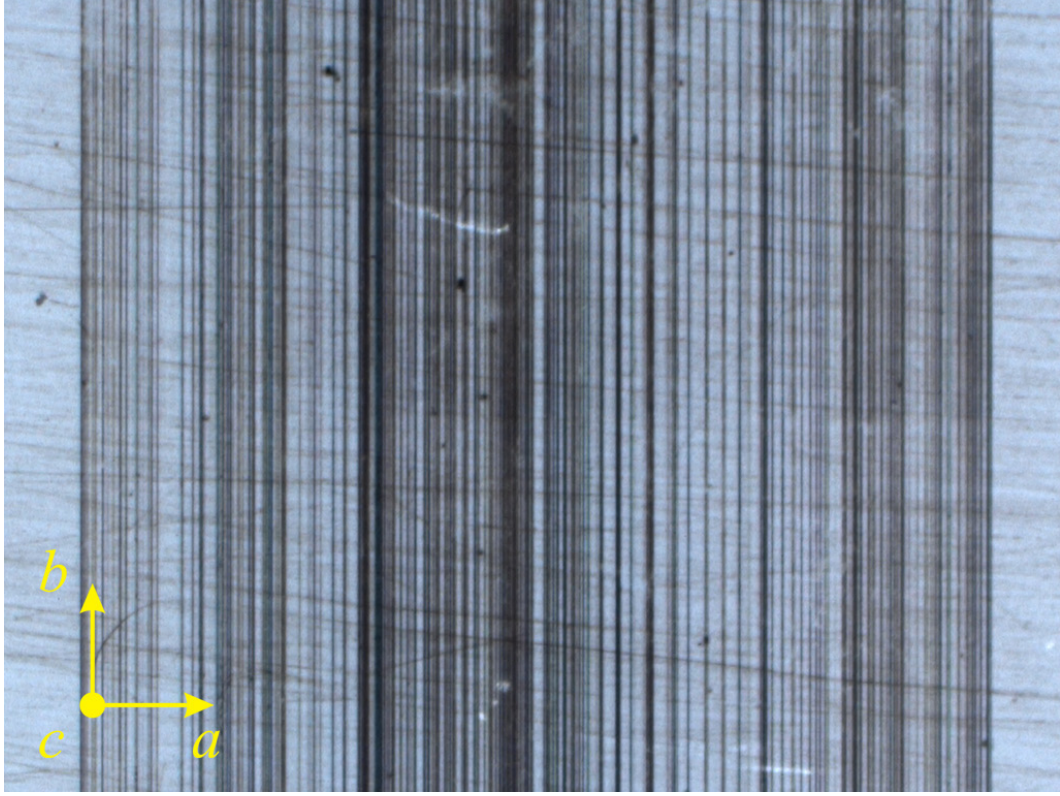
Figure 1. Domain structure in strontium tetraborate visualized by etching. Crystallographic axes are shown by arrows. Thickness of structure in a direction is 1